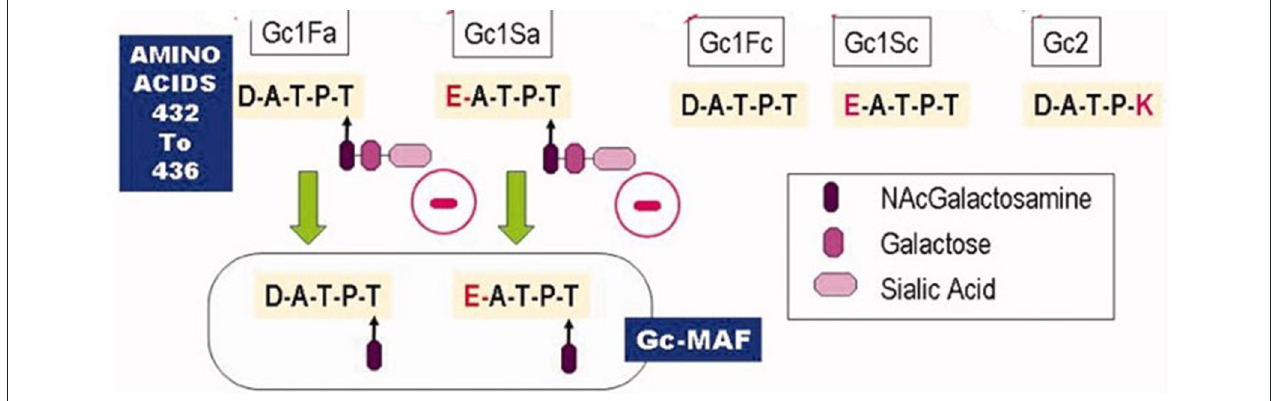
FIGURE 1 | The major DBP alleles. The amino acid differences between the three major DBP alleles are depicted. These differences affect not only their electrophoretic properties but also their glycosylation pattern. In particular Gc2 is not glycosylated, which prevents it from forming the DBP-macrophage activating factor (DBP-MAF). Other biologic differences are discussed in the